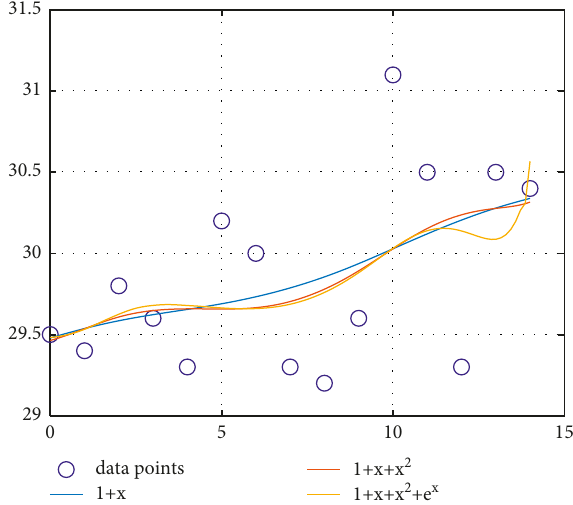
Figure 6: Moving least square simulation curve.